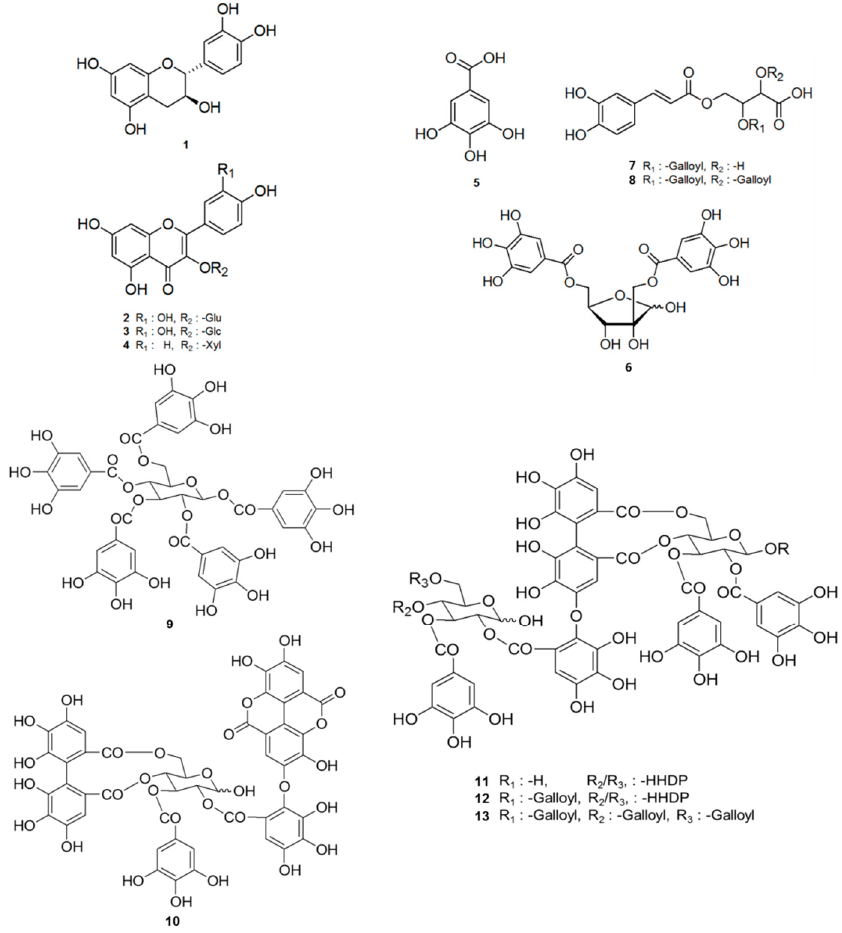
Figure 1. The structures of compounds 1 – 13 isolated from CA.